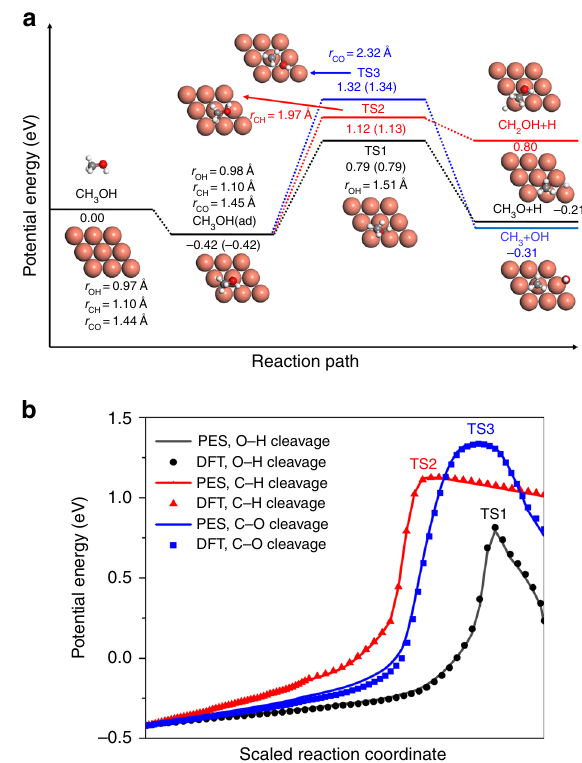
Fig. 1 Reaction pro fi le. a Energetics (in eV) and stationary point geometries (in Å) of O – H (black), C – H (red), and C – O (blue) bond cleavages for CH 3 OH dissociative chemisorption on Cu(111) computed by DFT. Energies in parentheses are obtained from the PES for comparison. b Minimum energy paths for these three dissociation channels on the permutation invariant polynomial neural network potential energy surface (solid lines) and DFT energies (symbols) recalculated at selected points along the respective reaction coordinate. Note that the reaction coordinate has been scaled to be in the same